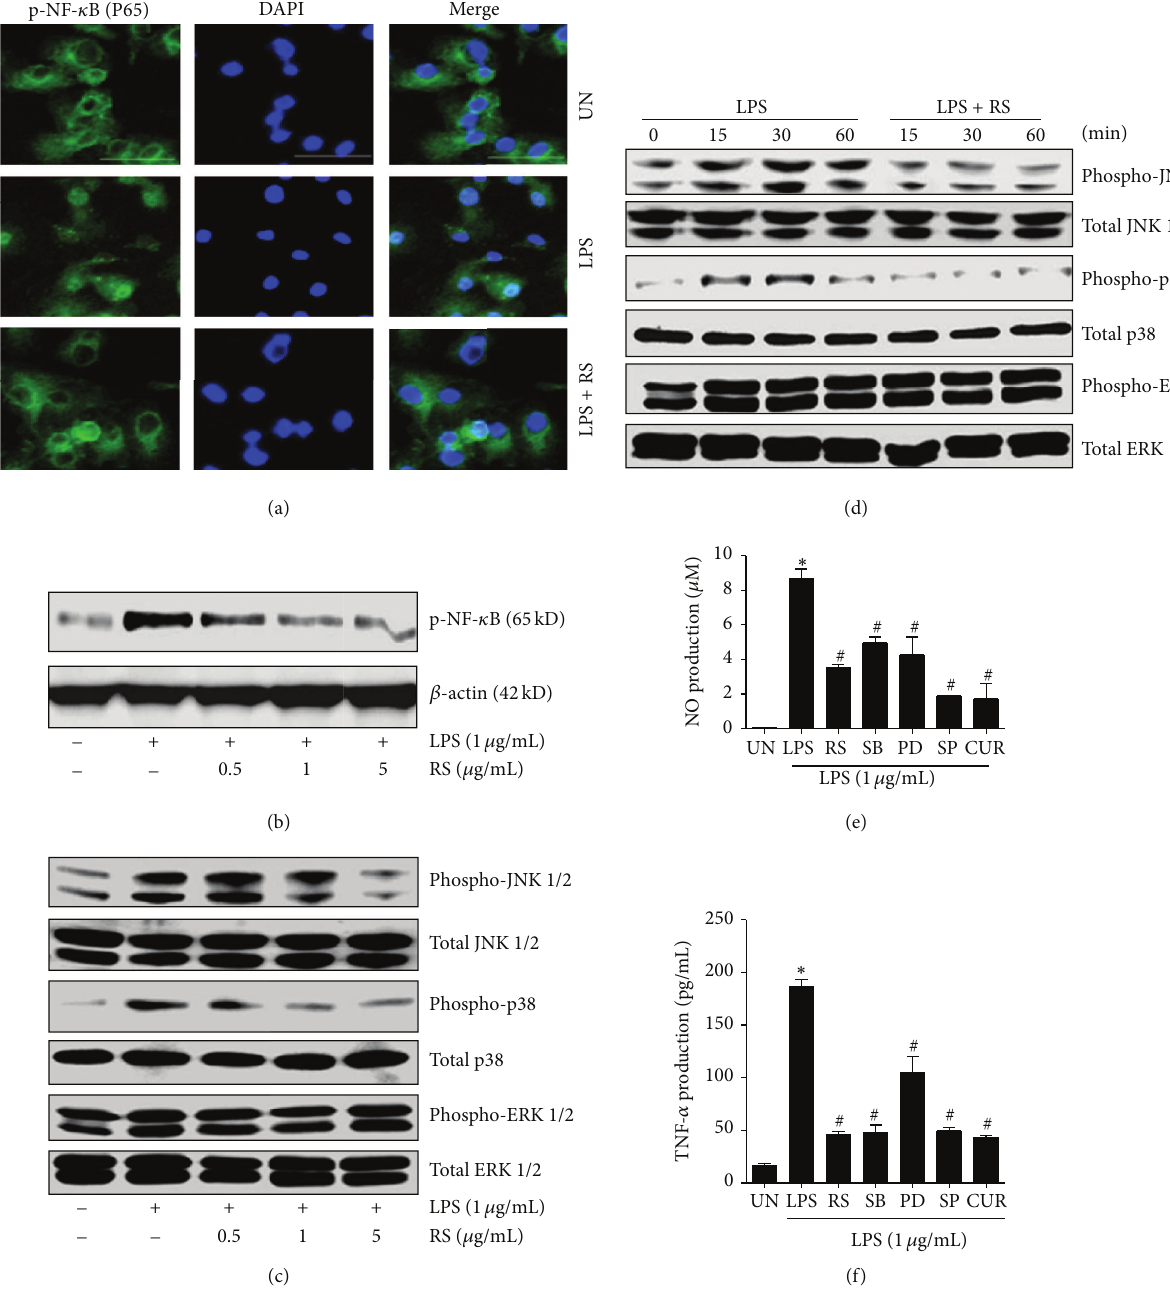
Figure 2: Effect of LPS-Rs on phosphorylation of NF- 𝜅 B and MAPKs and their indispensable role in LPS activated microglia. Microglia were pretreated with LPS-Rs followed by LPS for indicated time. Phosphorylation and translocation of p-65 NF- 𝜅 B were detected after 1hr by immunofluorescence (a) (scale bars = 50 𝜇 m) and Western blot (b). Phosphorylated and total protein expression of MAPKs was detected by Western blotting assay using specific antibodies (c, d). Production of TNF- 𝛼 (e) and nitric oxide (f) into the culture medium was analysed after 24 hrs by ELISA and Griess reagent, respectively. The error bars represent the mean ± SEM from three independent experiments ( ∗ 𝑝 ≤ 0.05 versus control and # 𝑝 ≤ 0.05 versus LPS). UN: untreated, LPS: lipopolysaccharide from Escherichia coli 055 : B5 (1 𝜇 g/mL), RS: lipopolysaccharide from Rhodobacter sphaeroides (0.5–5 𝜇 g/mL), SB: SB202190 (10 𝜇 M), PD: PD184352 (5 𝜇 M), SP: SP600125 (10 𝜇 M), and CUR: Curcumin (10 𝜇